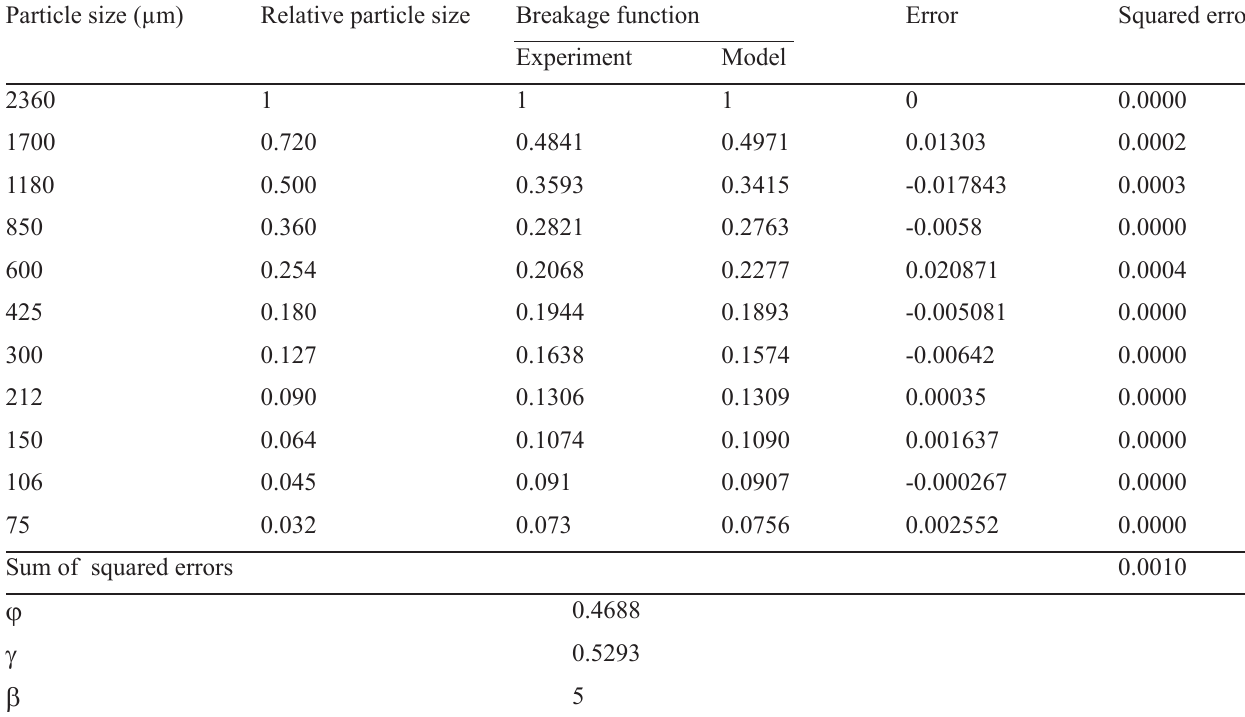
Table 3. The breakage function values for the microwave untreated -3350+2360 µm fraction.